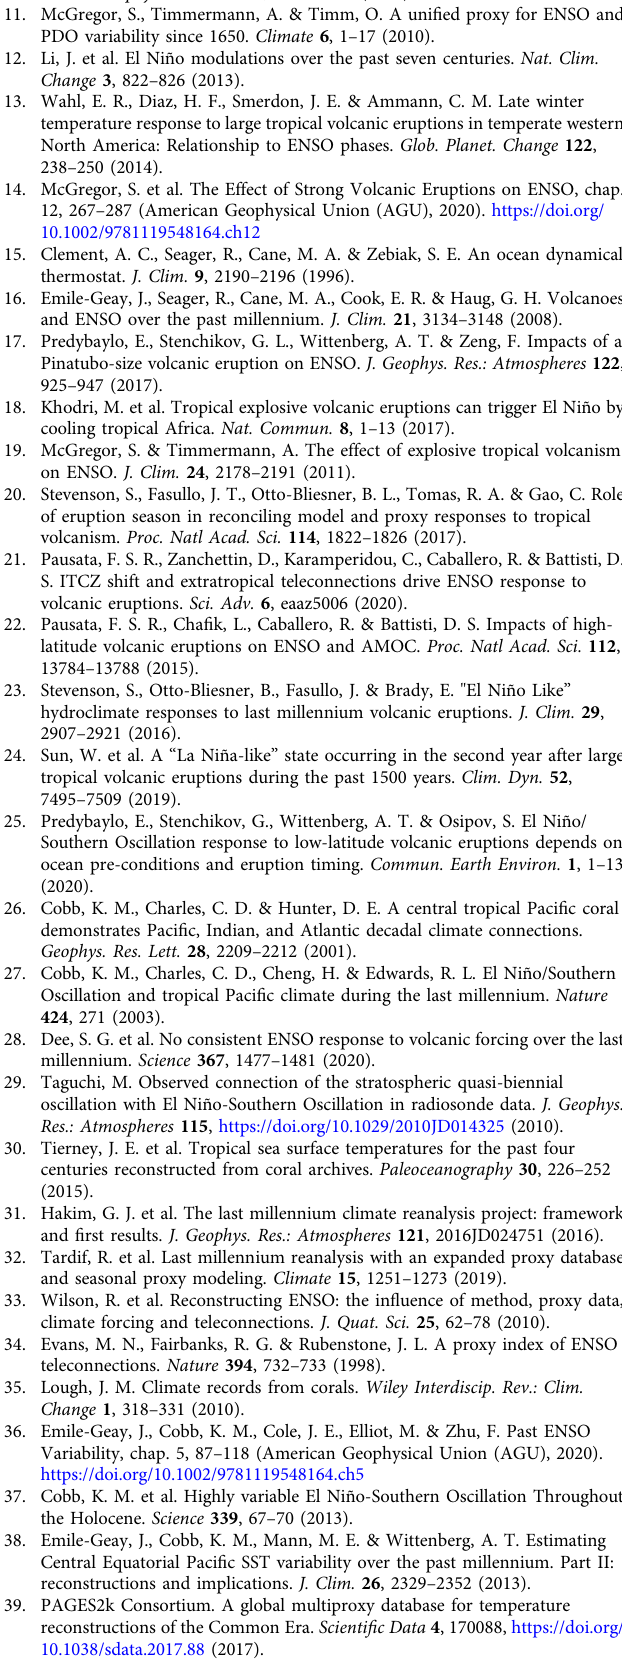
algorithm. Supplementary Fig. 13g – i show a temporal veri fi cation of each predictor against the Niño 3.4 series derived from ERSSTv5 as in Fig. 1d –